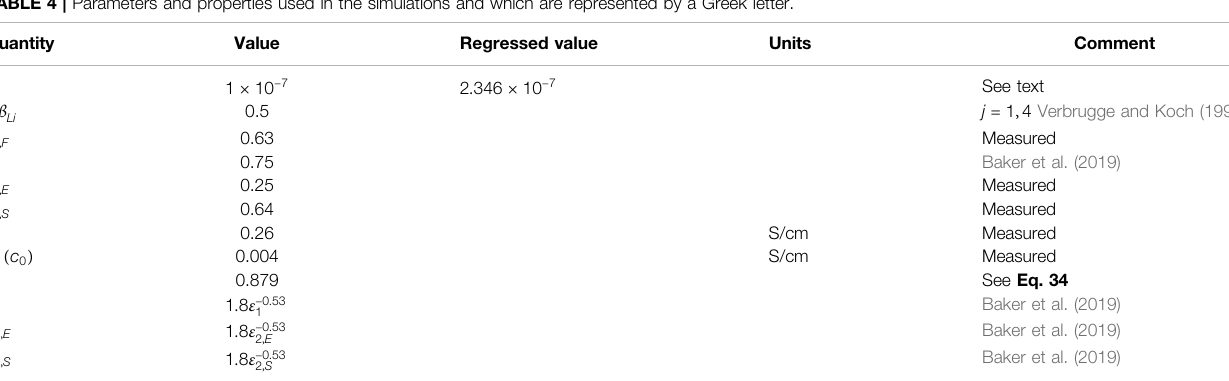
TABLE 4 | Parameters and properties used in the simulations and which are represented by a Greek